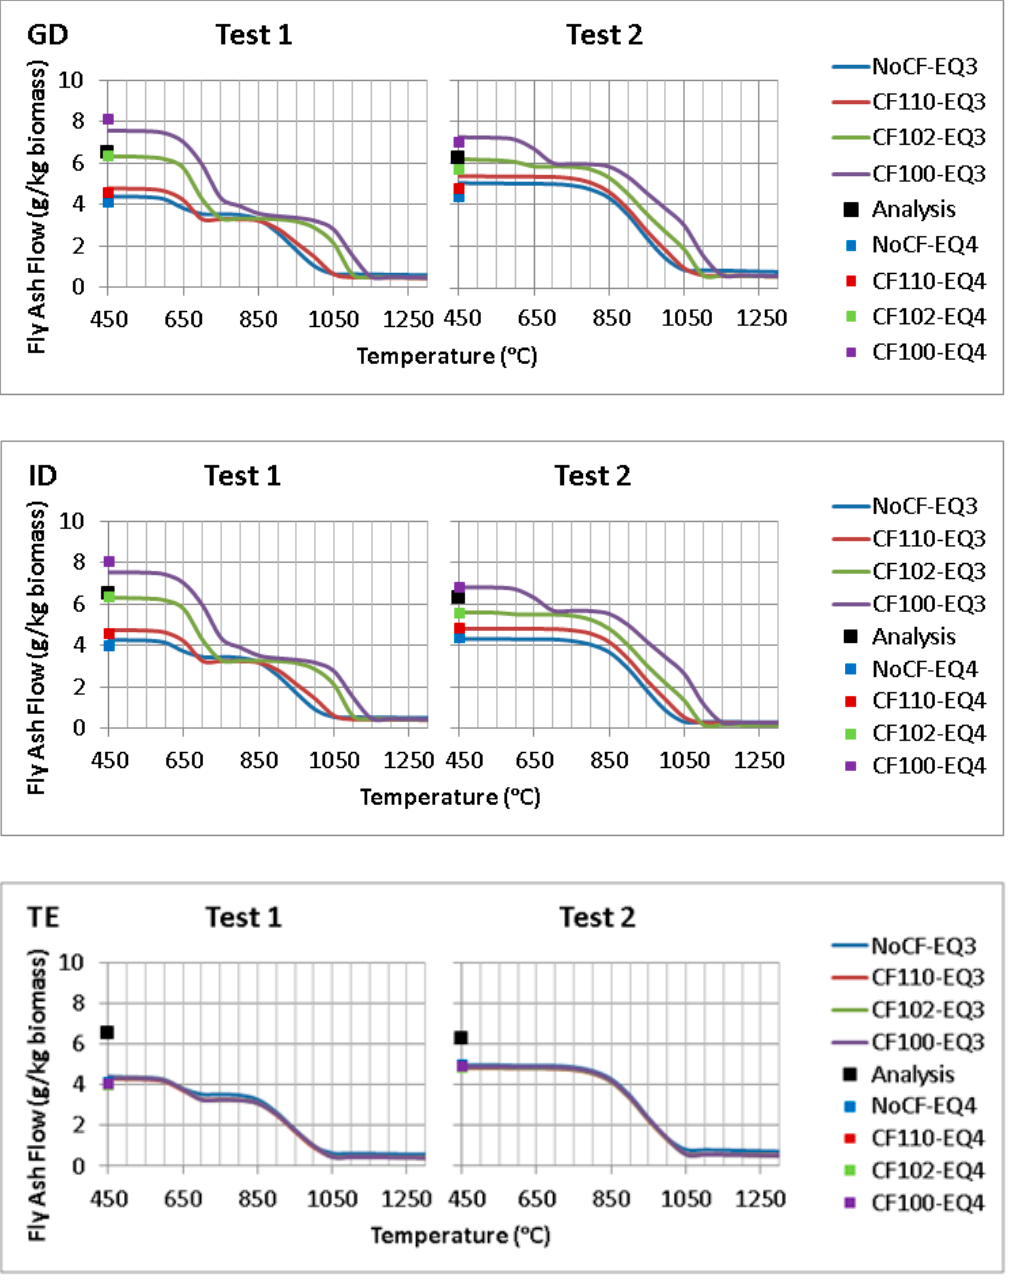
Figure 5. Results of the simulations for the fly ash flow rates in stages EQ3 and EQ4 according to the entrainment models GE ( top ), IE ( middle ), and TE ( bottom ). For each model, the four cases considered, as concerns chemical fractionation (CF100, CF102, CF110, and N°CF), are included. Black squares on the vertical axis correspond to the values measured onsite at the plant.